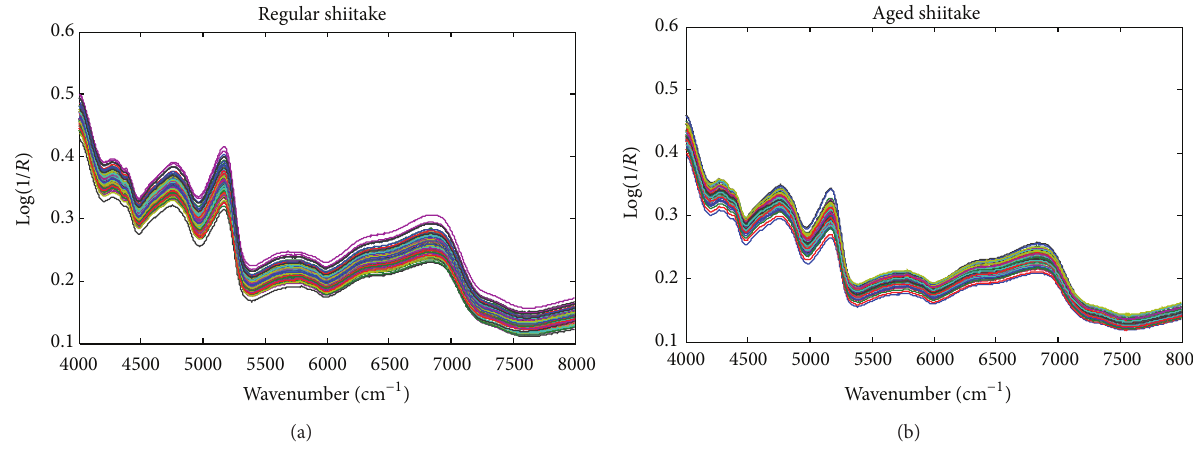
Figure 1: Raw NIR spectra of regular and aged shiitake